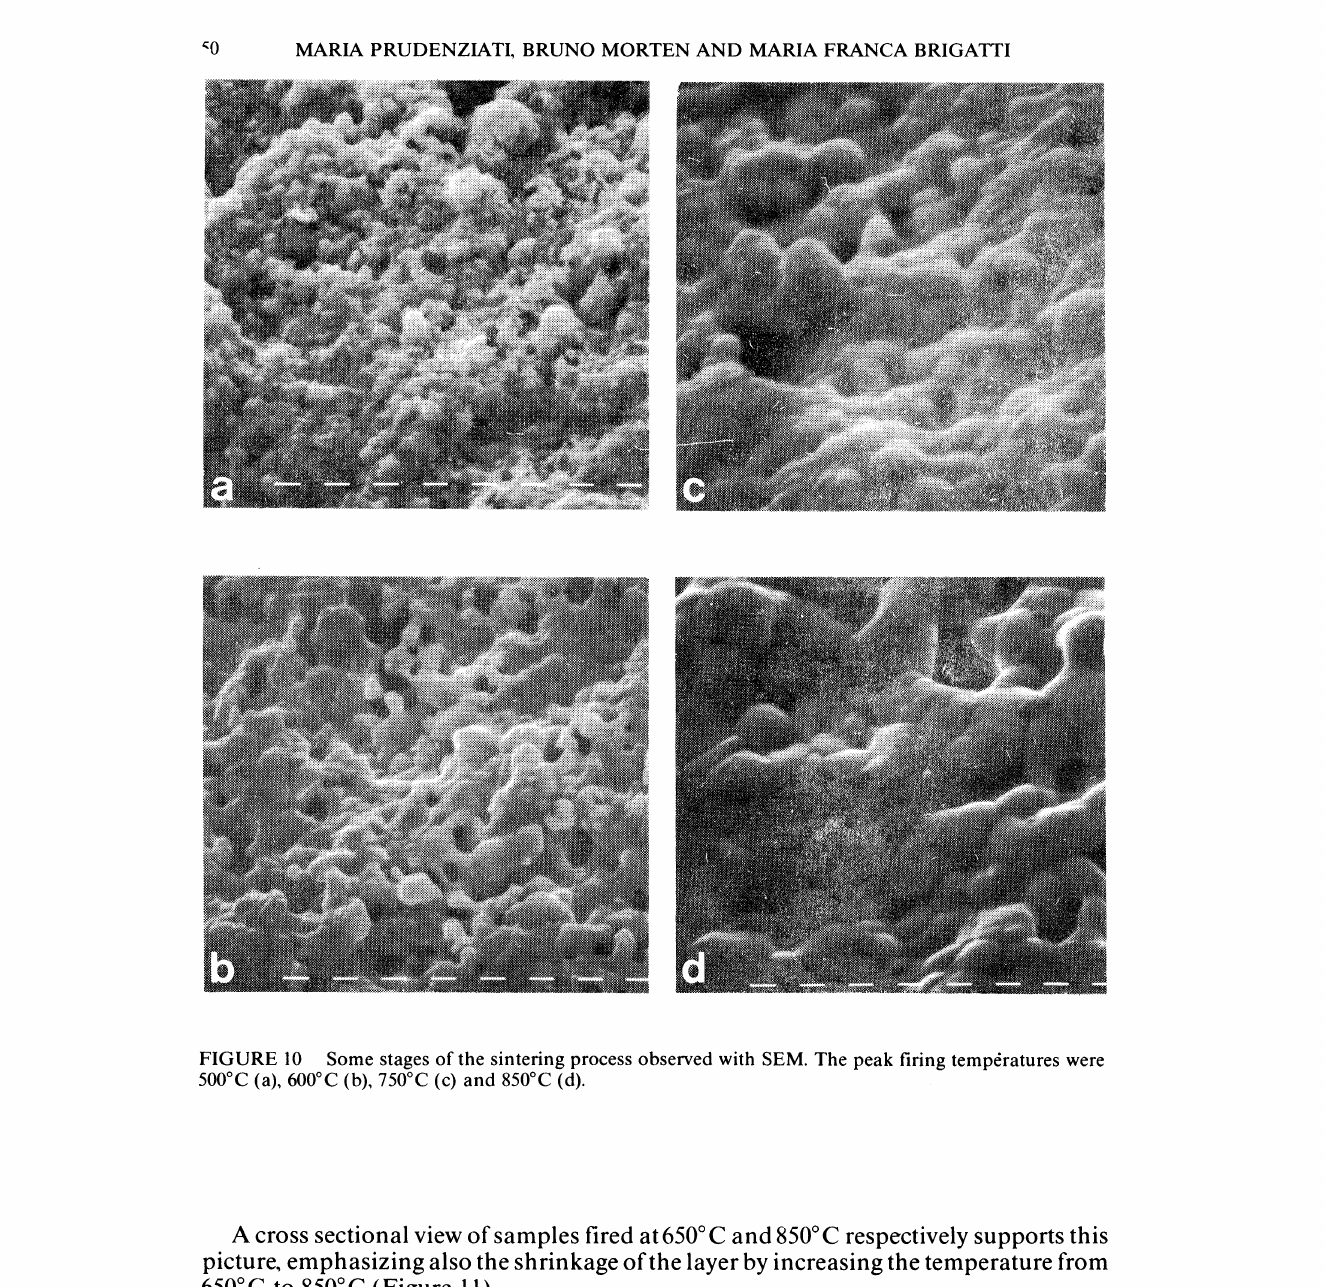
FIGURE 10 Some stages of the sintering process observed with SEM. The peak firing temperatures were 500C (a), 600C (b), 750C (c) and 850C